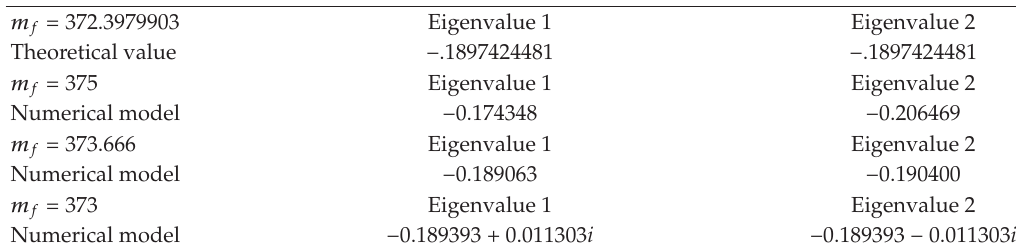
Figure 4: Stretch ratio for inviscid CSF, viscous CSF, and viscoelastic model. Table 2: Eigenvalues for hyperelastic model with varying m f